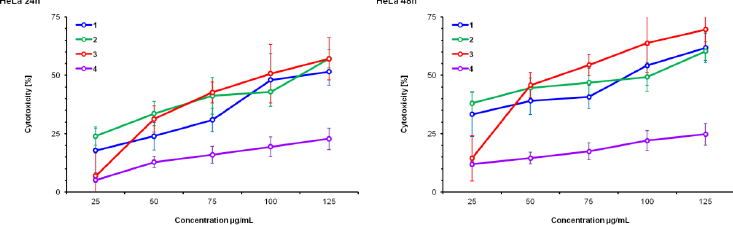
Figure 1. Cytotoxicity percentage determined by MTT test on HeLa, after 24 h and 48 h exposures to V. vinifera extracts in a concentration ranging from 25 µ g/mL to 125 µ g/mL. (1) Dry extract—DE; (2) (2) subcritical water extract — SWE; (3) resveratrol — R; (4) maltodextrin — M. subcritical water extract—SWE; (3) resveratrol—R; (4) maltodextrin—M.